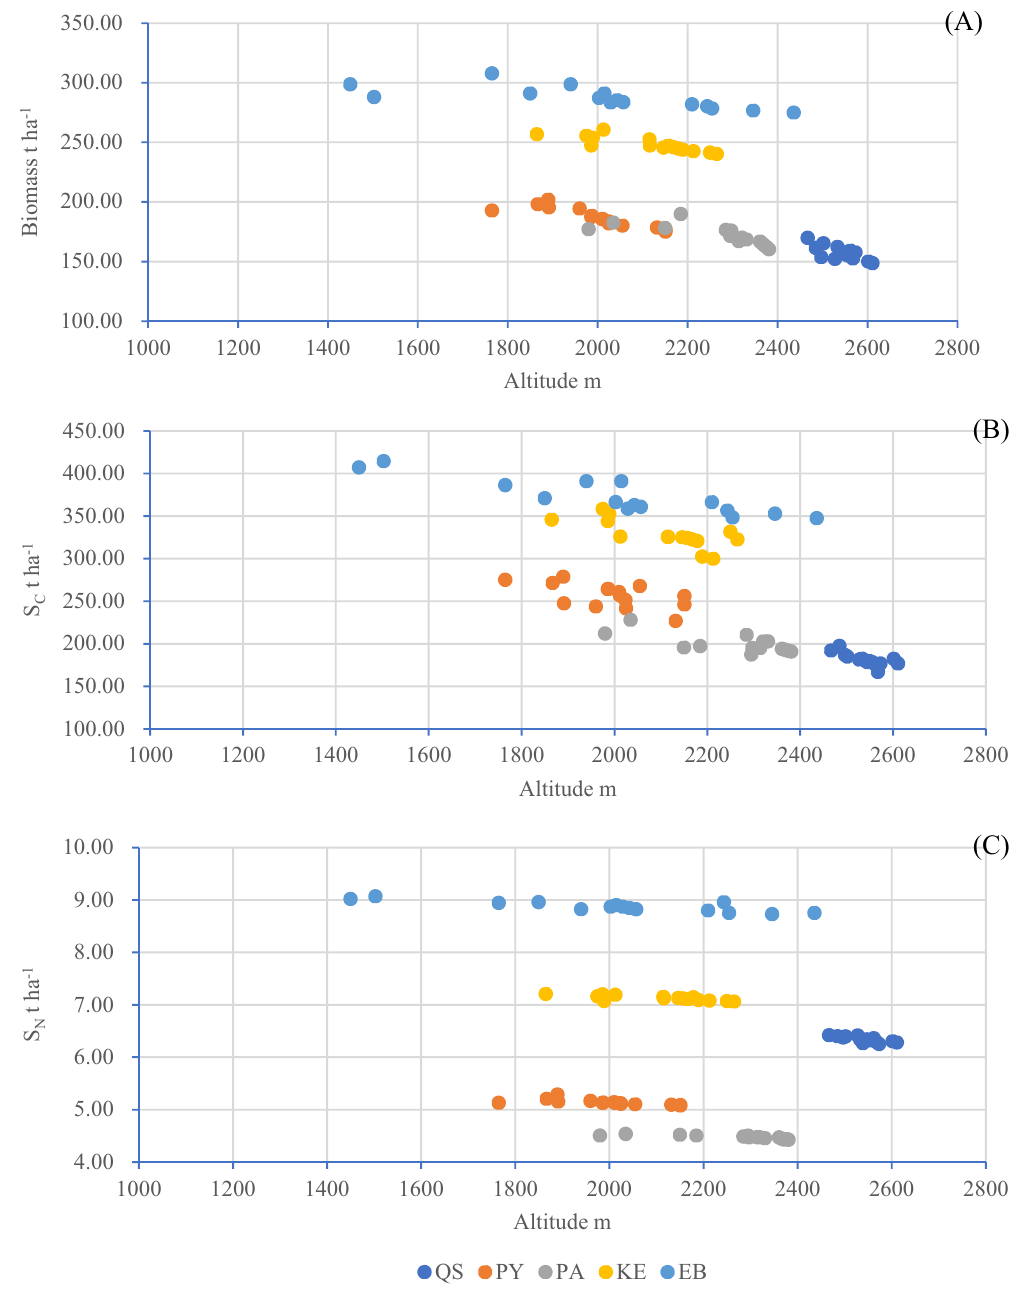
Figure 4. Altitudinal patterns of biomass, S C and S N of different forests in the central Yunnan